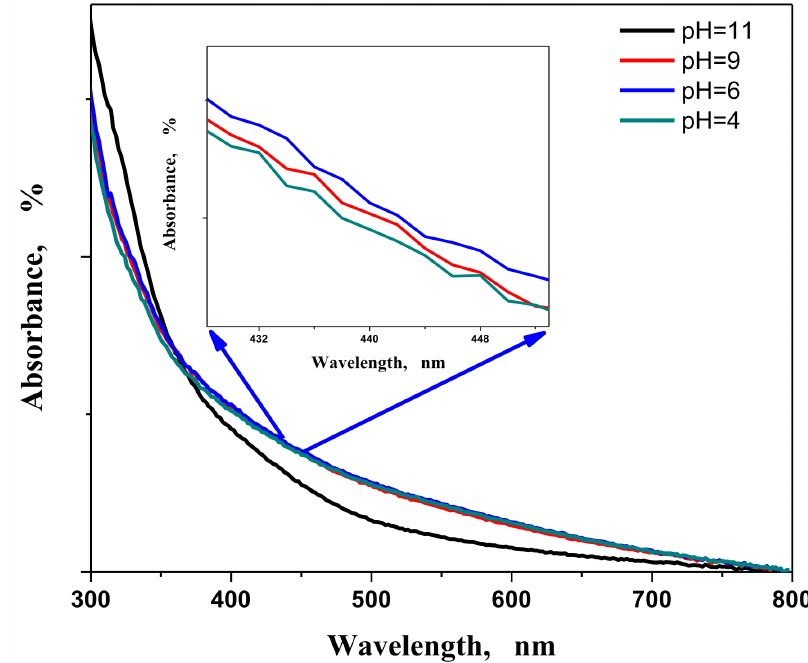
Figure 4. The impact of pH on biosynthesis of palladium